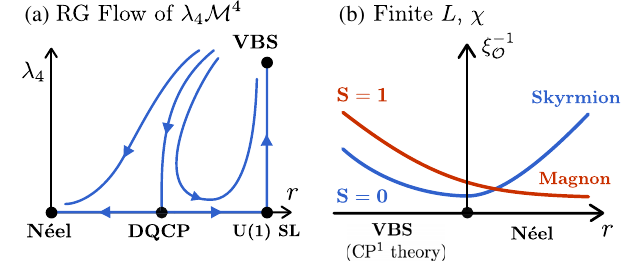
FIG. 8. (a) RG flow of the quadrupled monopole term λ 4 M 4 in the square lattice DQCP scenario, which is dangerously irrel- evant. For a small deviation of the tuning parameter J 1 =J 2 toward the VBS phase, λ 4 initially decreases under RG flow until the RG scale reaches the spin-spin correlation length. Only after that does λ 4 begin to increase to reach the VBS fixed point. This result has noticeable consequences for observables in a finite size numerical simulation. (b) Schematic plot for the inverse correlation length ξ − 1 of spin-singlet and -triplet operators as a function of the tuning parameter for the square lattice DQCP scenario with either O(4) or SO(5) emergent symmetries. Note that ξ − 1 is related to the energy (mass gap) of the associated excitation [32]. Here, the skyrmion corresponds to the Higgsed “ photon ” excitation in the CP 1 theory. In the VBS phase, this photon excitation manifests as a spin-singlet VBS order parameter fluctuation, i.e., the VBS domain wall thickness. Similarly, the magnon becomes a “ trip- lon ” in the VBS phase. The plot assumes the simulation of the DQCP at the finite circumference L and bond dimension χ , which prevents ξ from diverging at the